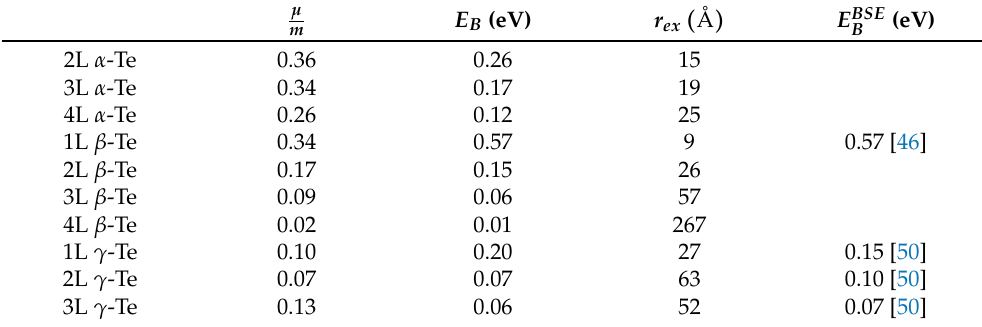
Figure 9. Numerical solutions of the 2D exciton model, for E B / R ex (red) and r ex / a ex (blue), as expressed by Equation (5), showing the two limits discussed. E B and r ex are the exciton binding energy and radius, respectively; R ex = R H µ is the 3D hydrogenoid Rydberg R H , renormalised by m the ratio between the effective reduced mass µ and the free electron mass m ; a ex = a B m is the Bohr µ radius a B , renormalised by the free electron mass and the effective reduced mass ratio. Results for Te are all from this work. Credits to [37–39] for the other results reported (see top left inset): InN (green), GaN and Graphane (grey), BN (orange), AlN (cyan), Plumbene:H (magenta). Table 3. Exciton binding energy ( E B ) and radius ( r ex ), as calculated within the Rytova-Keldysh model, compared to reported GW-BSE results in literature ( E BSE ). Extrapolated exciton reduced mass B renormalised with respect to the free electron mass ( µ / m ) is also